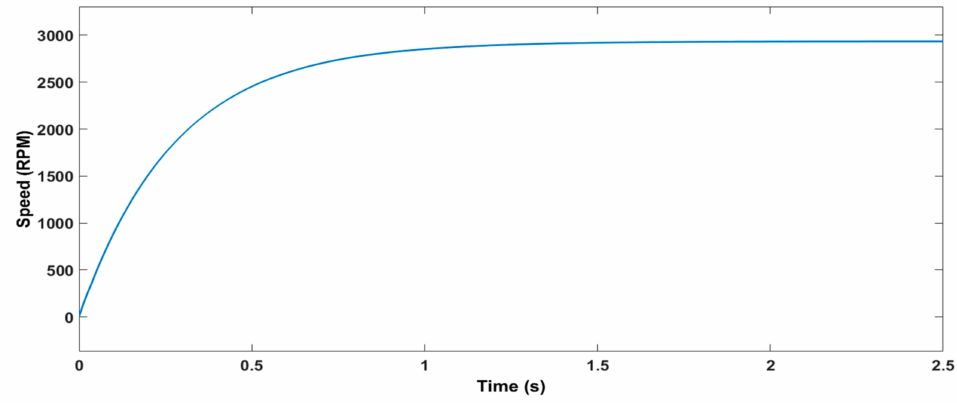
Figure 17. Speed of BLDC motor at battery SOC 95%.